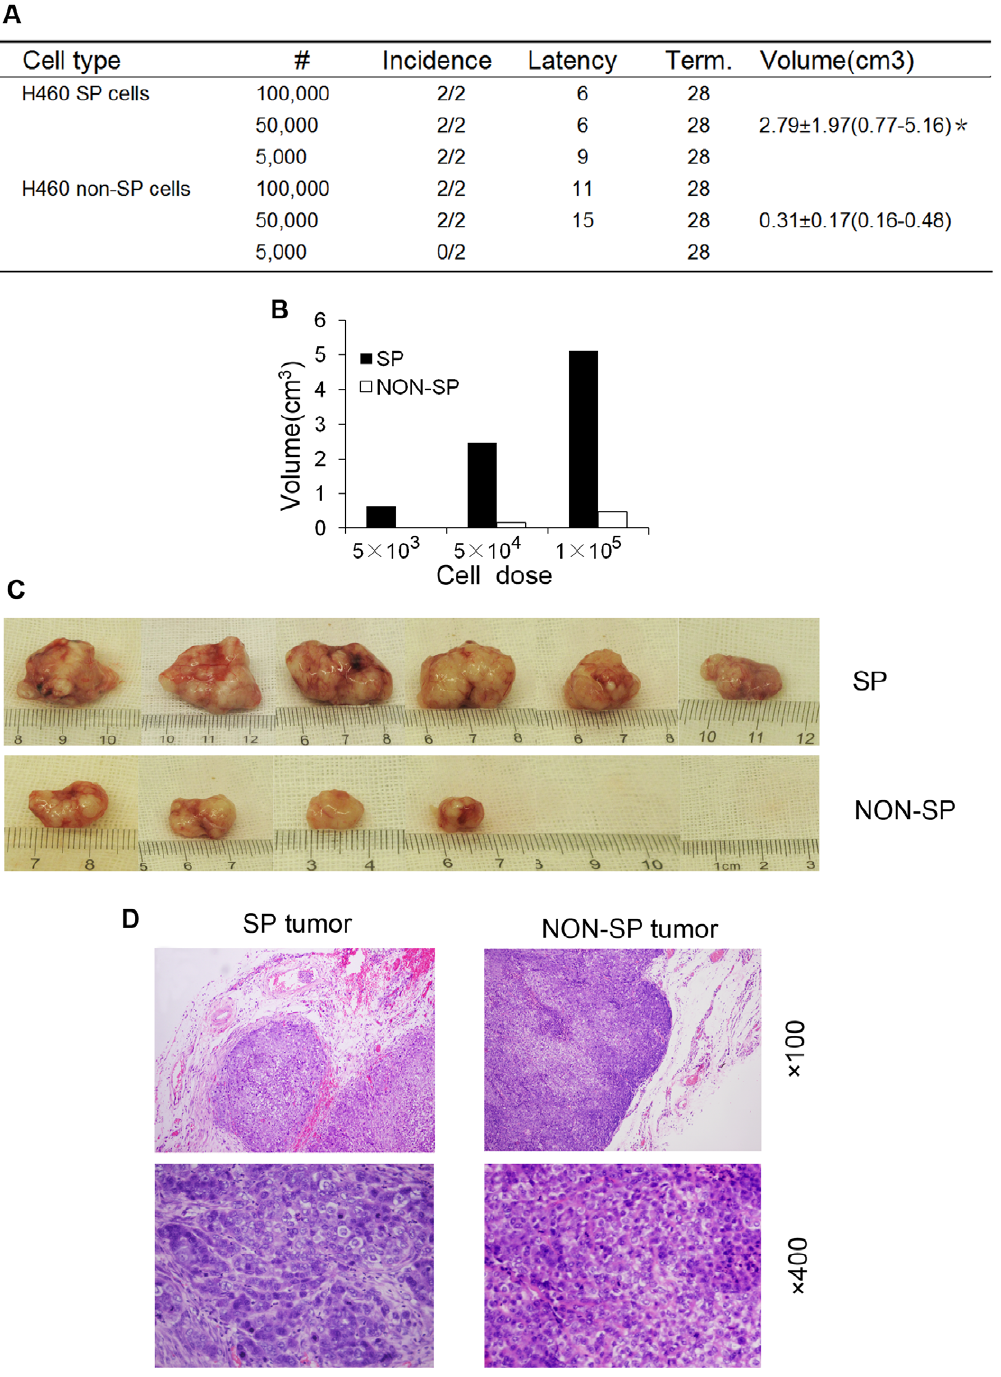
Figure 4. High tumorigenicity in SP cells. A, Table presentation of the tumorigenic potential of H460 SP and non-SP cells. Three parameters of tumorigenicity, i.e., tumor incidence, latency, and volume (* P , 0.01) were shown. All animals were terminated (term.) 28 days after implantation. B, The SP cells regenerated larger tumors than corresponding non-SP cells at every cell dose. C, Gross tumor images when tumors were harvested at day 28 after s.c. injection of the SP and non-SP cells into NOD/SCID mice. D, Representative HE-stained photomicrographs of SP and non-SP tumors.